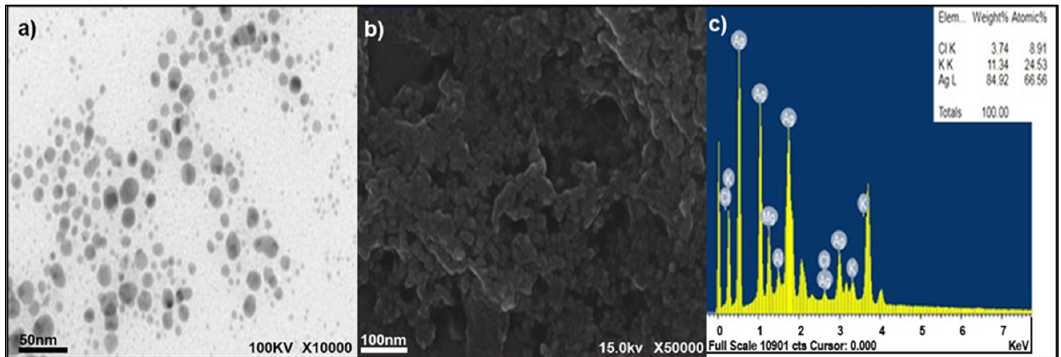
Figure 1. Characterization of fungal silver nanoparticles AgNPs ( a ) TEM micrograph of biosynthesized AgNPs, ( b ) SEM micrograph of biosynthesized AgNPs, and ( c ) energy dispersive spectroscopy EDS micrograph of biosynthesized silver AgNPs.